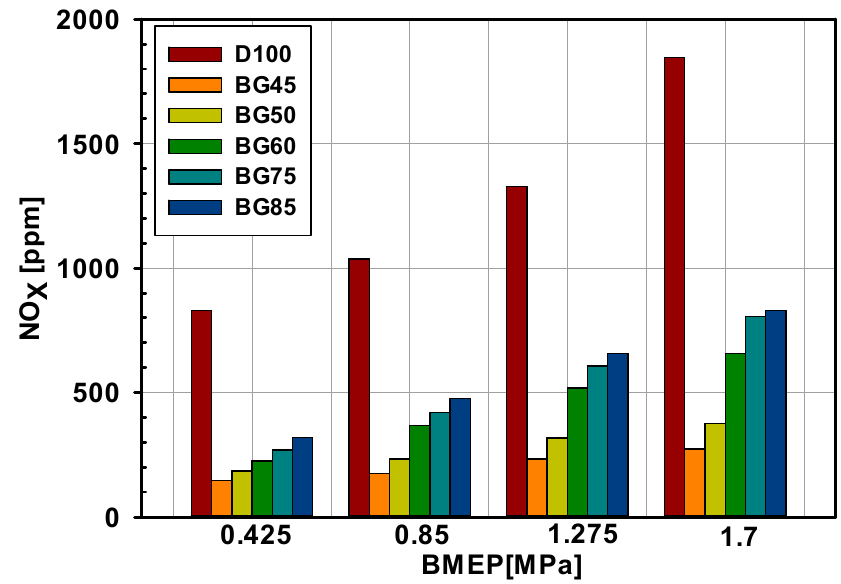
Figure 14. Variation of NO X emissions with engine load.